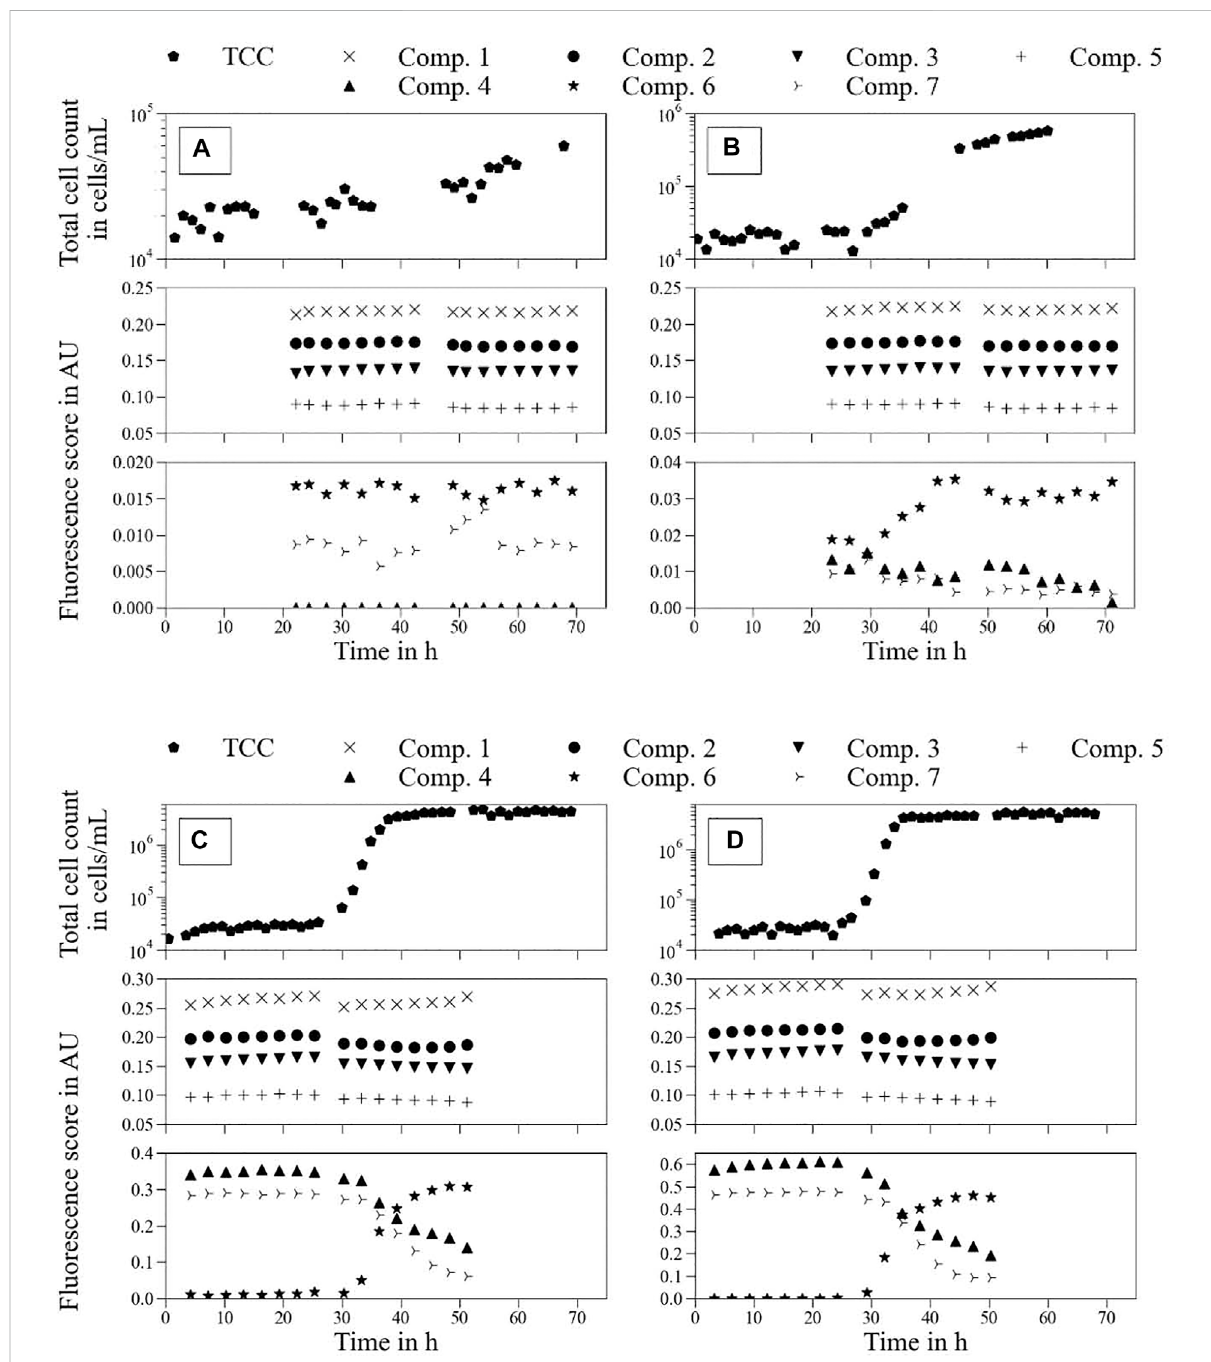
FIGURE 6 Real-time monitoring of total cell count (TCC) and fl uorescence score in arbitrary units (Components 1 – 7) over an experimental period of approximately 70 h. Tap water samples with different LB medium concentrations: (A) — S1 tap water; (B) — S2 tap water + vol% 0.001 LB medium; (C) — S5 tap water + vol% 0.029 LB medium; (D) — S6 tap water + vol% 0.043 LB